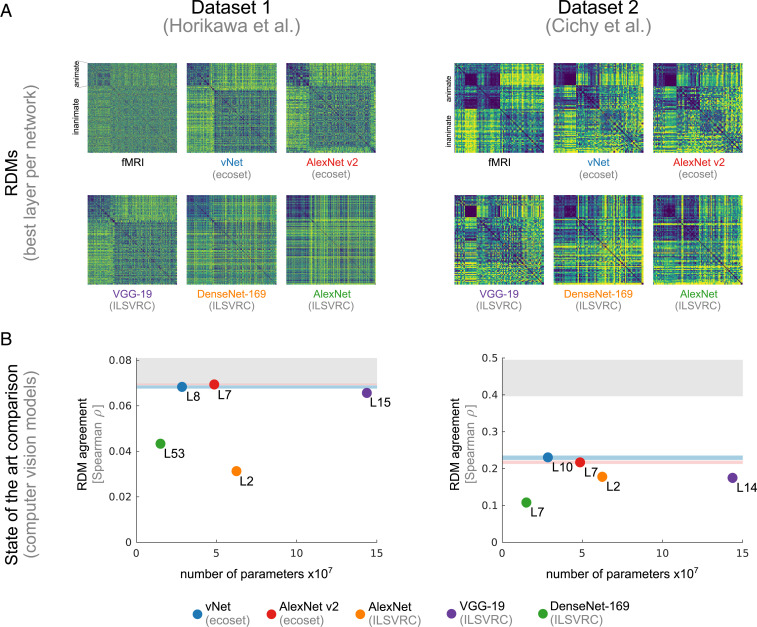
Comparing ecoset-trained DNNs to the state of the art. (A) Target RDMs from human HVC shown together with RDMs extracted from various deep neural network models (best layer selected for each with dataset 1 on the left and dataset 2 on the right). (B) Agreement with human HVC plotted against model parametric complexity. vNet and AlexNet v2, both trained on ecoset, significantly outperform state of the art DNN models pretrained on ILSVRC 2012 (DenseNet-169, VGG-19, and the original AlexNet). Error bars shown in blue and red indicate 95% CI.